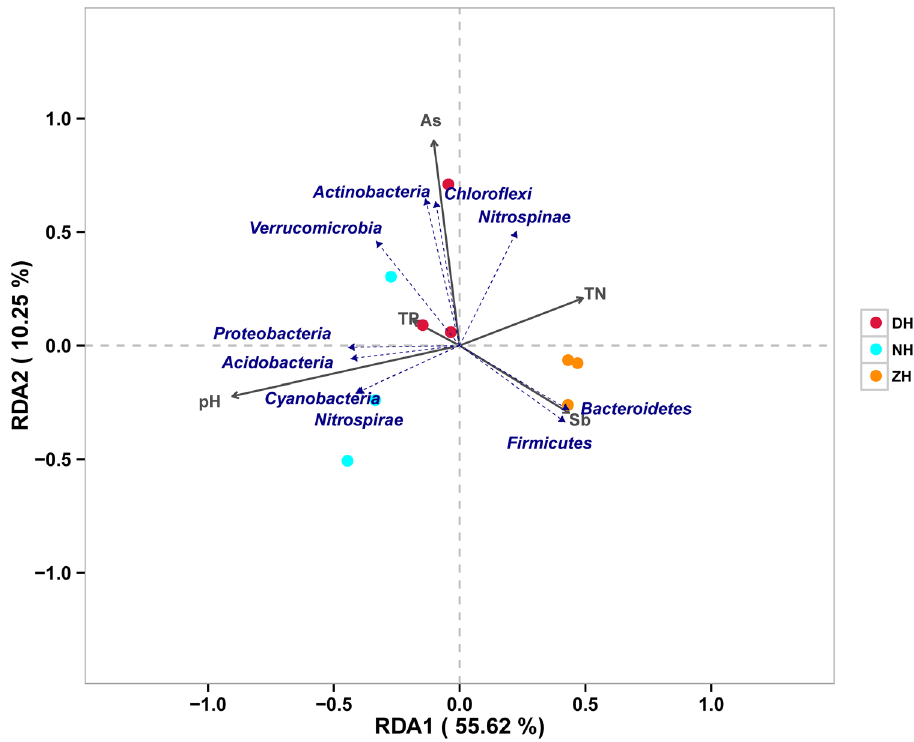
Figure 6. Redundancy analysis of horizontal dominant bacteria and physicochemical factors in